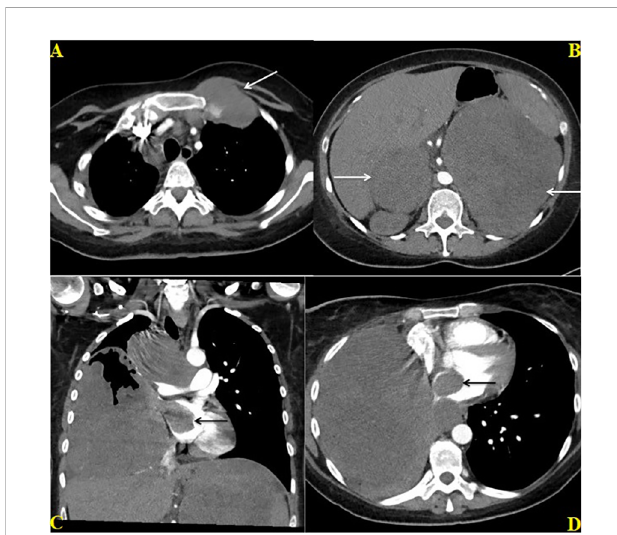
FIGURE 2 Contrast enhanced CT chest and abdomen dated June 27, 2022; Axial CT image through the chest (A) shows enlarged metastatic pre and paratracheal lymph nodes and a lobulated metastatic mass involving the left fi rst rib (white arrow) at the costochondral junction. Axial CT image through the upper abdomen (B) shows large bilateral adrenal masses (white arrows). Coronal (C) and Axial (D) CT images through the chest shows a large hetereogenously enhancing mass in the right lung directly extending through the right superior pulmonary vein into the right atrium (black arrow) and conglomerate paratracheal lymphadenopathy (C)